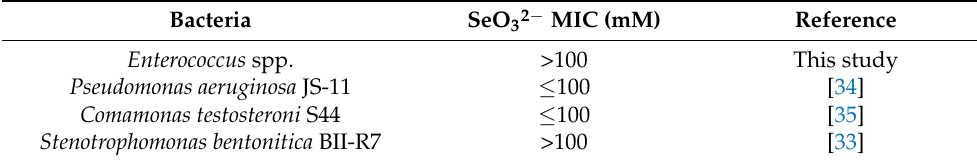
Table 1. Comparison of MICs between Enterococcus spp. and other selenite-reducing bacteria.